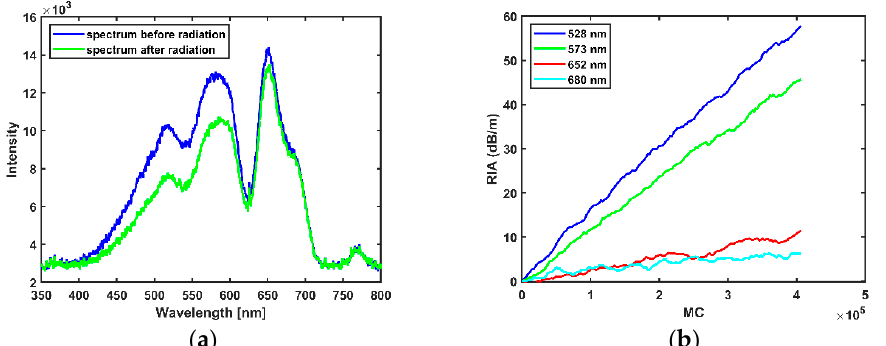
Figure 5. ( a ) Wavelength spectrum before and after radiation in the Bragg peak. ( b ) Dependence of the RIA on MC.